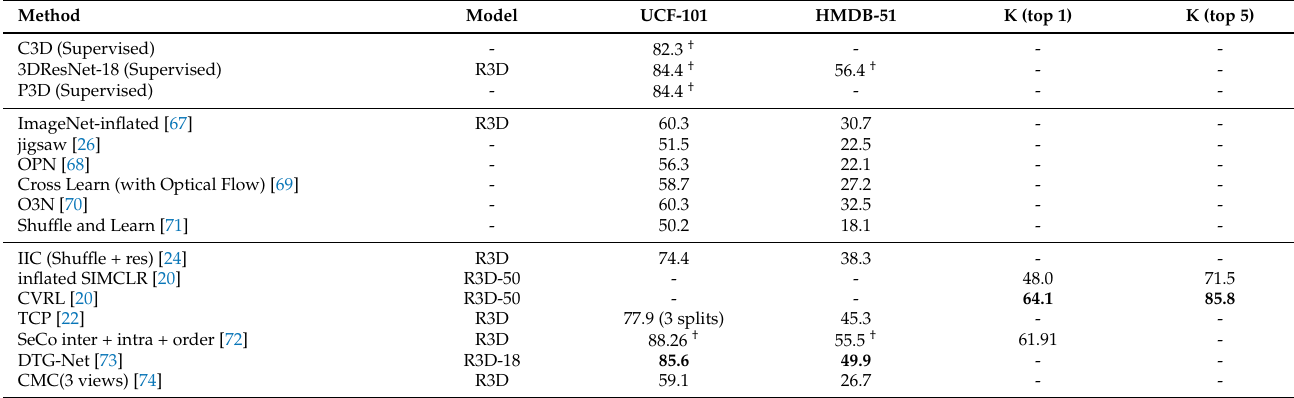
Table 4. Accuracy on Video Classification. All the proposed methods were pretrained with their proposed contrastive based approaches and a linear model was used for validation. R3D in model represents 3D-ResNet. † represents that the model has been trained on another dataset and further fine-tuned with the specific dataset. K represents Kinetics